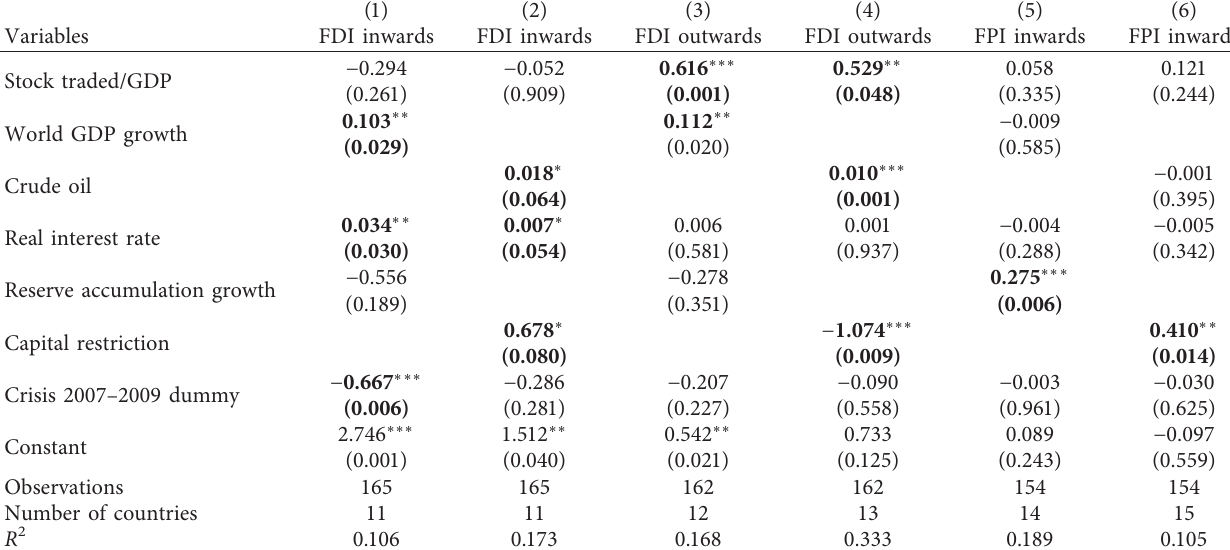
Table 8: Regression analysis in eleven emerging